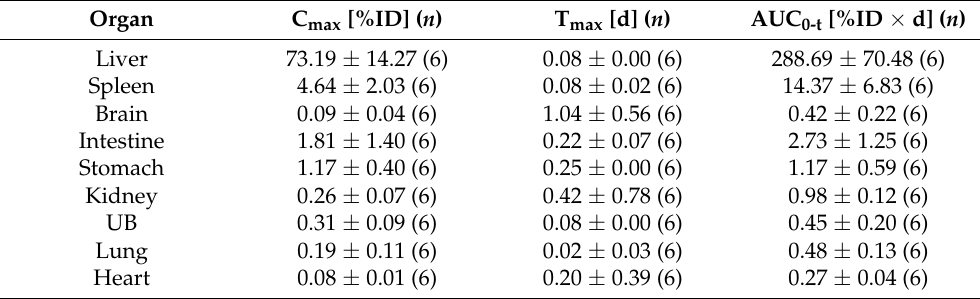
Table 1. In vivo pharmacokinetic parameters of 89 Zr-Exo following i.v. administration in various organs of ICR mice.